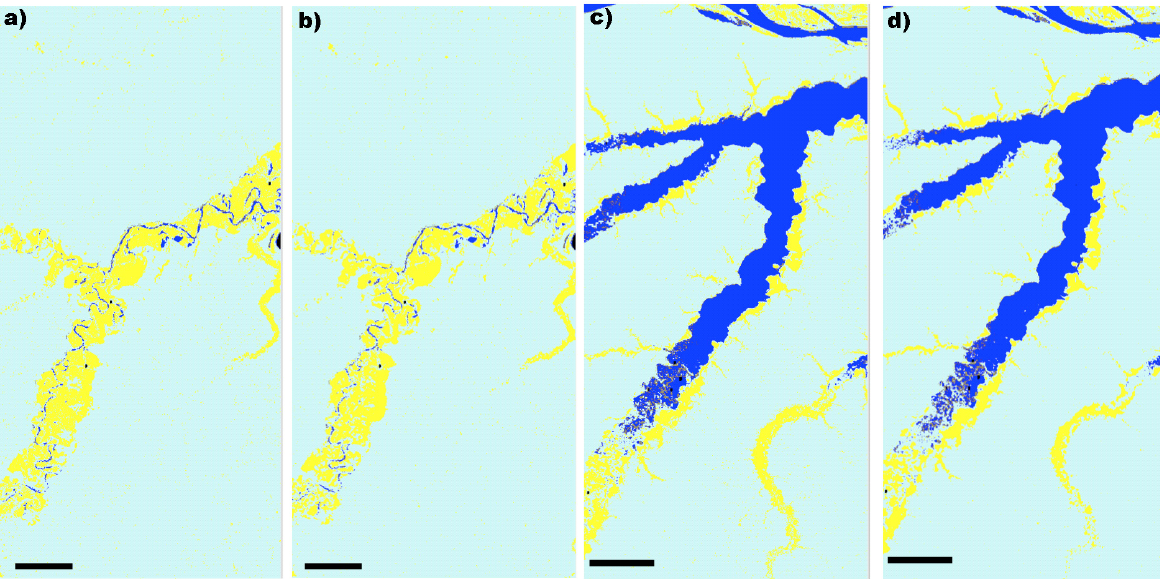
Figure 5. HH backscatter threshold versus incidence angle for the detection of inundation, derived empirically such that similar classifications were obtained in the near and far range of overlapping images acquired five days apart.